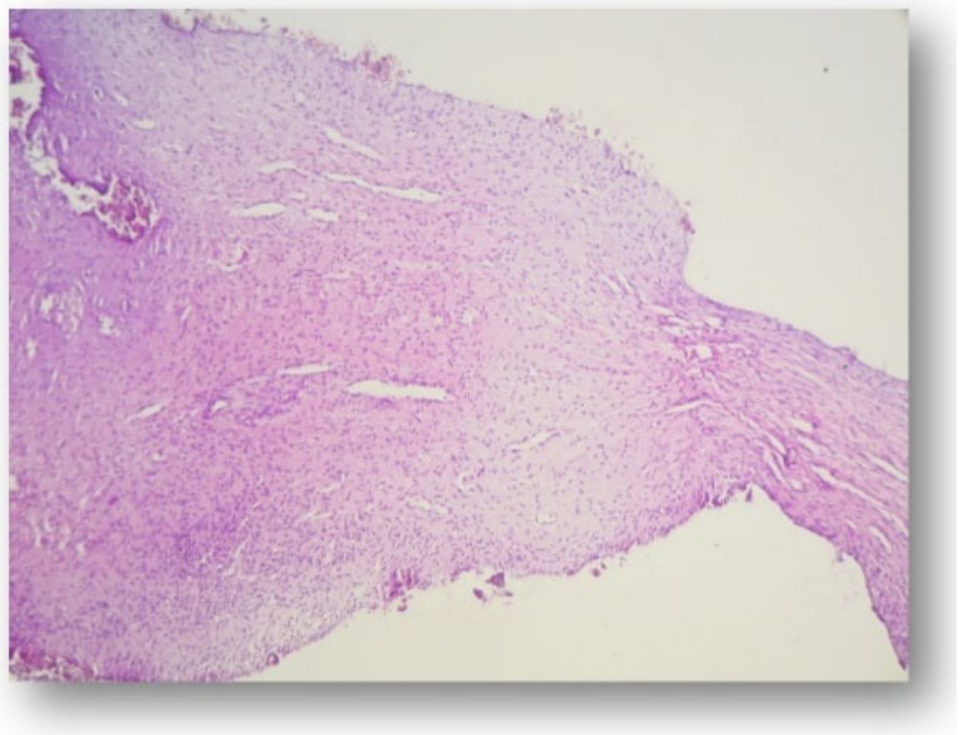
Figure 1. The corono-radicular pulp tissue of a healthy 47 year old female, with discrete leukocyte infiltration, few areas of sclerosis, HE staining, ×100.